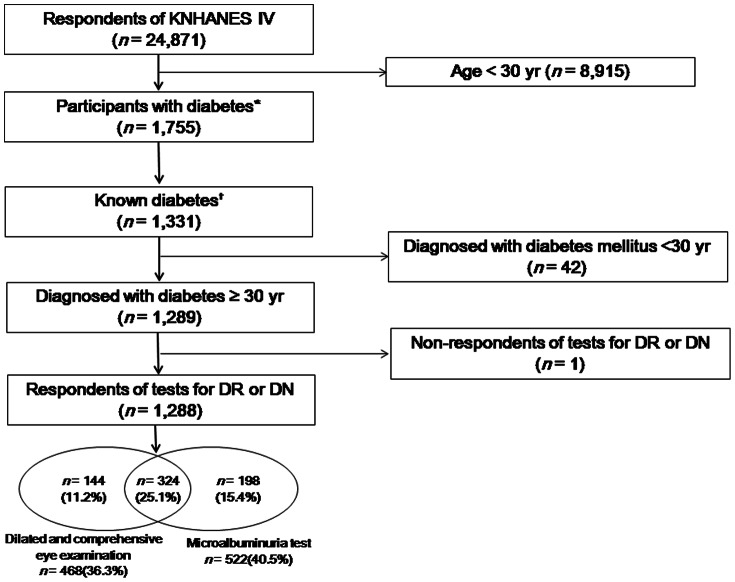
Study population framework. KNHANES, Korean National Health and Nutrition Examination Survey; DR, diabetic retinopathy; DN, diabetic nephropathy.*Subjects with fasting plasma glucose ≥126 mg/dL or a previous diagnosis of diabetes by a clinician, or who were taking insulin or oral antidiabetic medication. †Subjects diagnosed with diabetes by a clinician or taking insulin or oral antidiabetic agents.